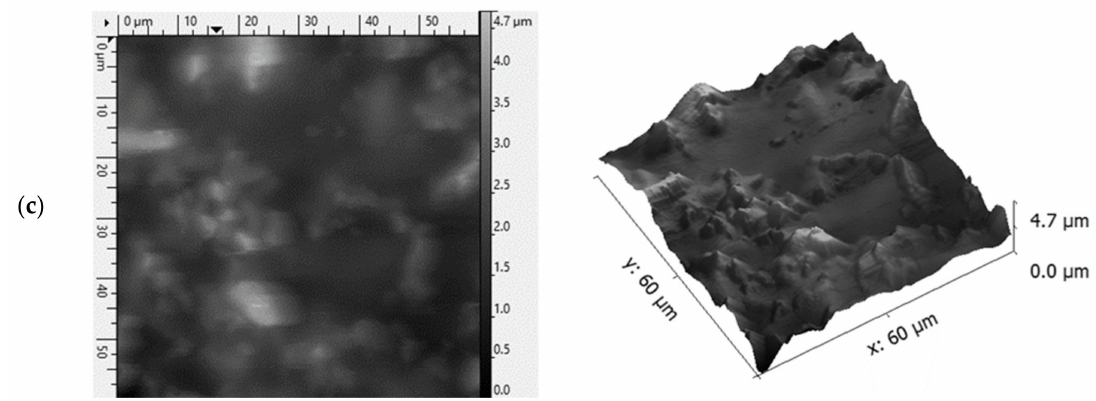
Figure 3. Atomic force microscopy (AFM) images (2D) and topography (3D) of HPMC ODF: ( a ) Upper surface of a drug-free film, ( b ) lower surface of an LO film, ( c ) upper surface of an LO film (30% w / w of LO in casting mass).